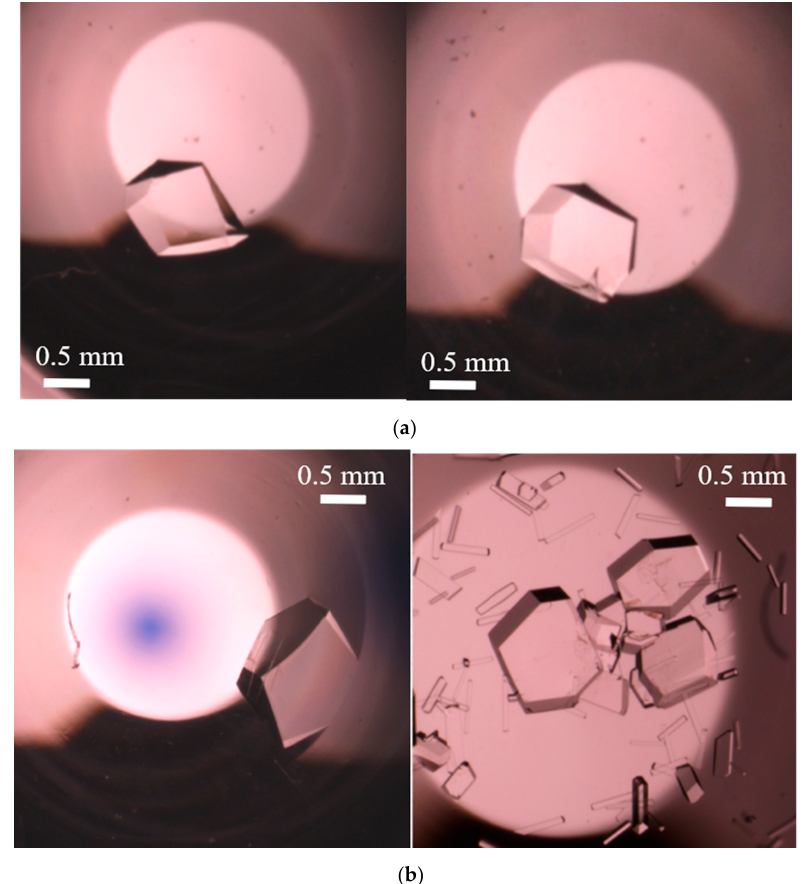
Figure 4. HEWL crystal shapes with and without a magnetic field. ( a ) Without a magnetic field (0 T); ( b ) with magnetic field (200